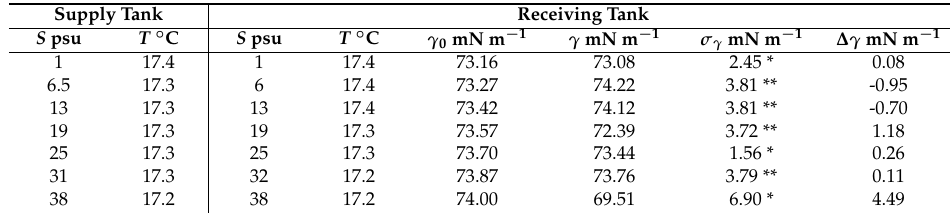
Table 1. Summary of the controlled parameters: salinity S , water temperature T , calculated surface tension of pure NaCl solution γ 0 (calculated for each S and T following [10] (their Appendix B)), measured surface tension γ , standard deviation of the measured surface tension σ γ , surface film pressure ∆ γ (calculated as ∆ γ = γ 0 − γ